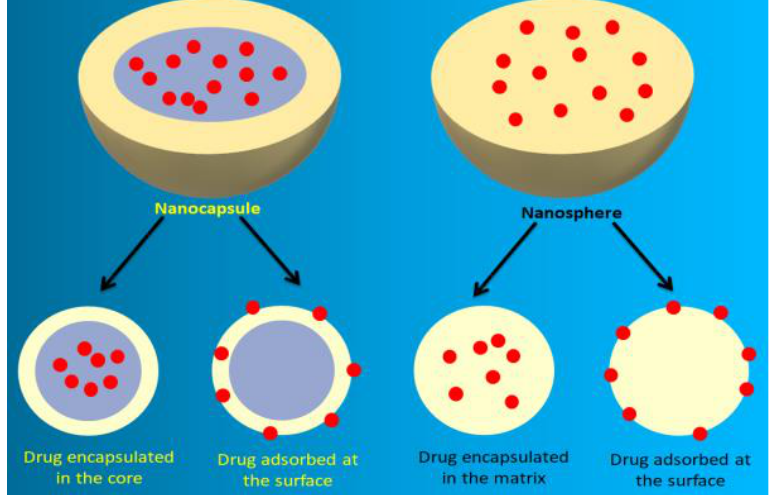
Figure 3. Classification of polymeric nanoparticles according to structural organization.